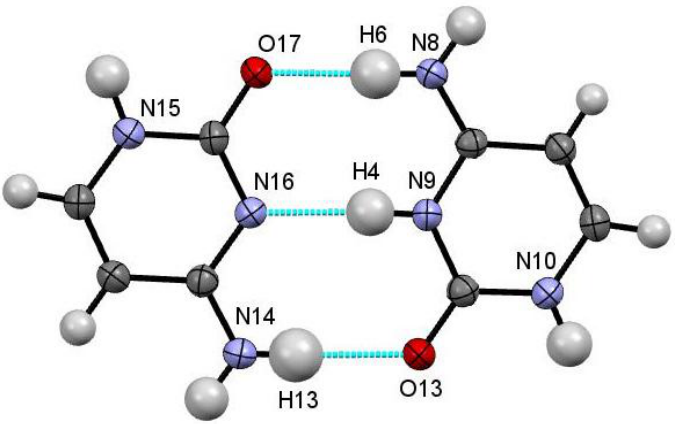
Figure 5. A cytosine dimer with pseudo Watson-Crick hydrogen bonding arrangement within